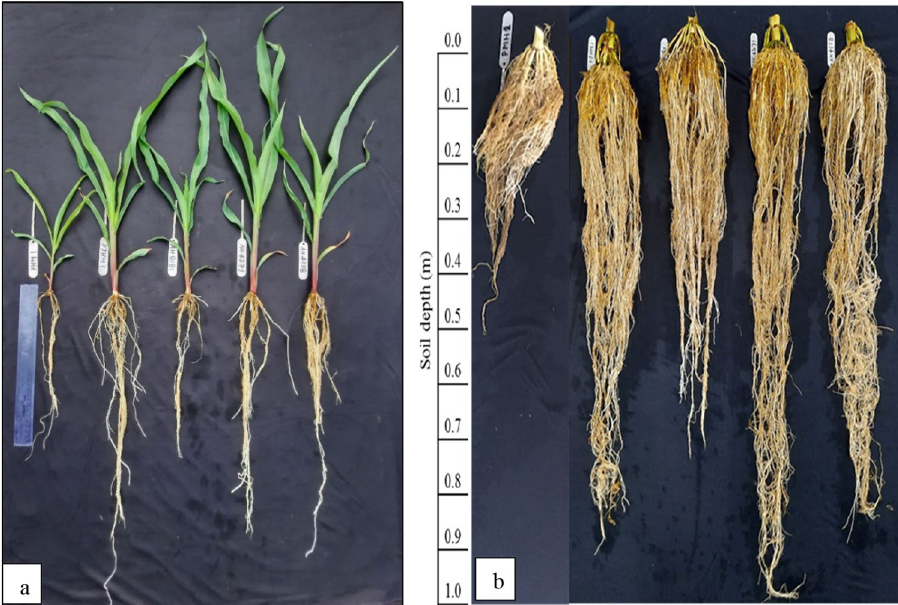
Figure 9. Destructively measured root growth pattern of the maize genotypes (PMH-1, PJHM-1, AH-8181, AH-4271, AH-4158) grown in PVC tubes under the field conditions at V5 stage (20 days after sowing, DAS) ( a ) and at 53 DAS ( b